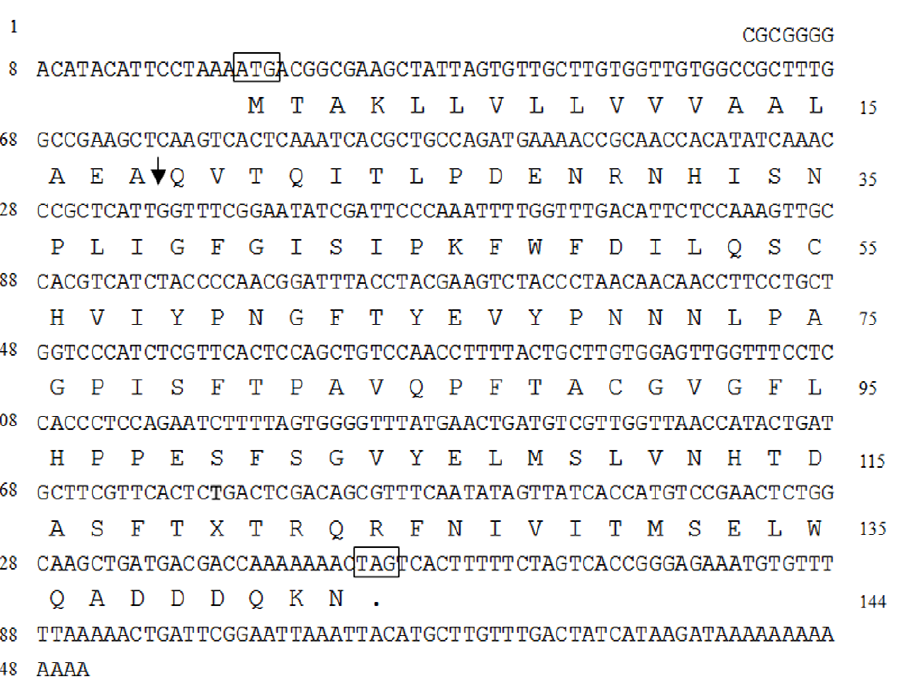
Figure 5. Nucleotide and deduced amino acid sequences of Slmg7 cDNA. The numbers on the left show the nucleotide sequence and the numbers on the right show the amino acid sequence. The start codon and the stop codon are boxed. The arrow indicates the predicted cleavage site of a signal peptide of 18 amino acids. The GenBank accession number of this cDNA is JF964955.